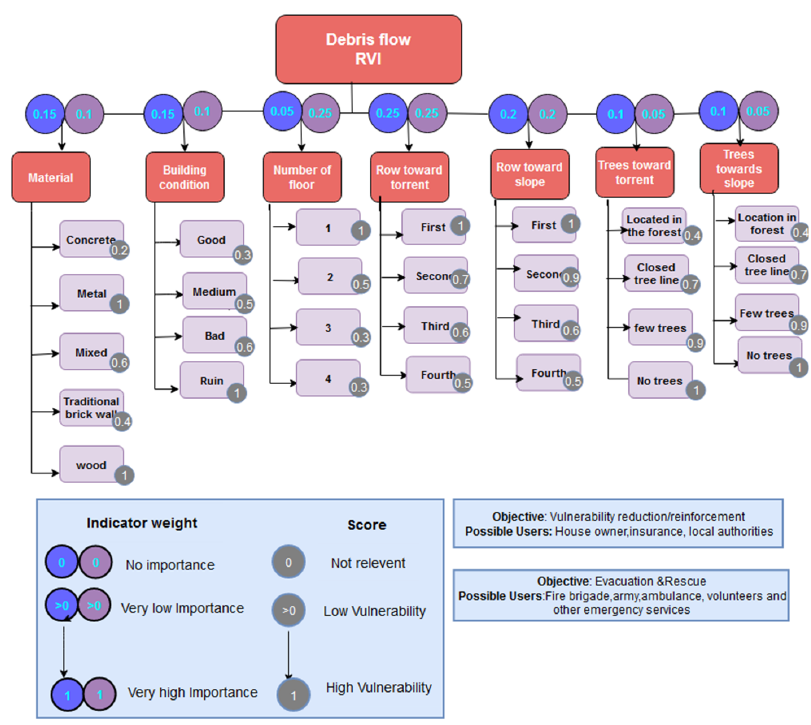
Figure 8. Example of the vulnerability indicators is demonstrated together with the weight index and scores which can vary according to the objective of the study and the end ‐ users